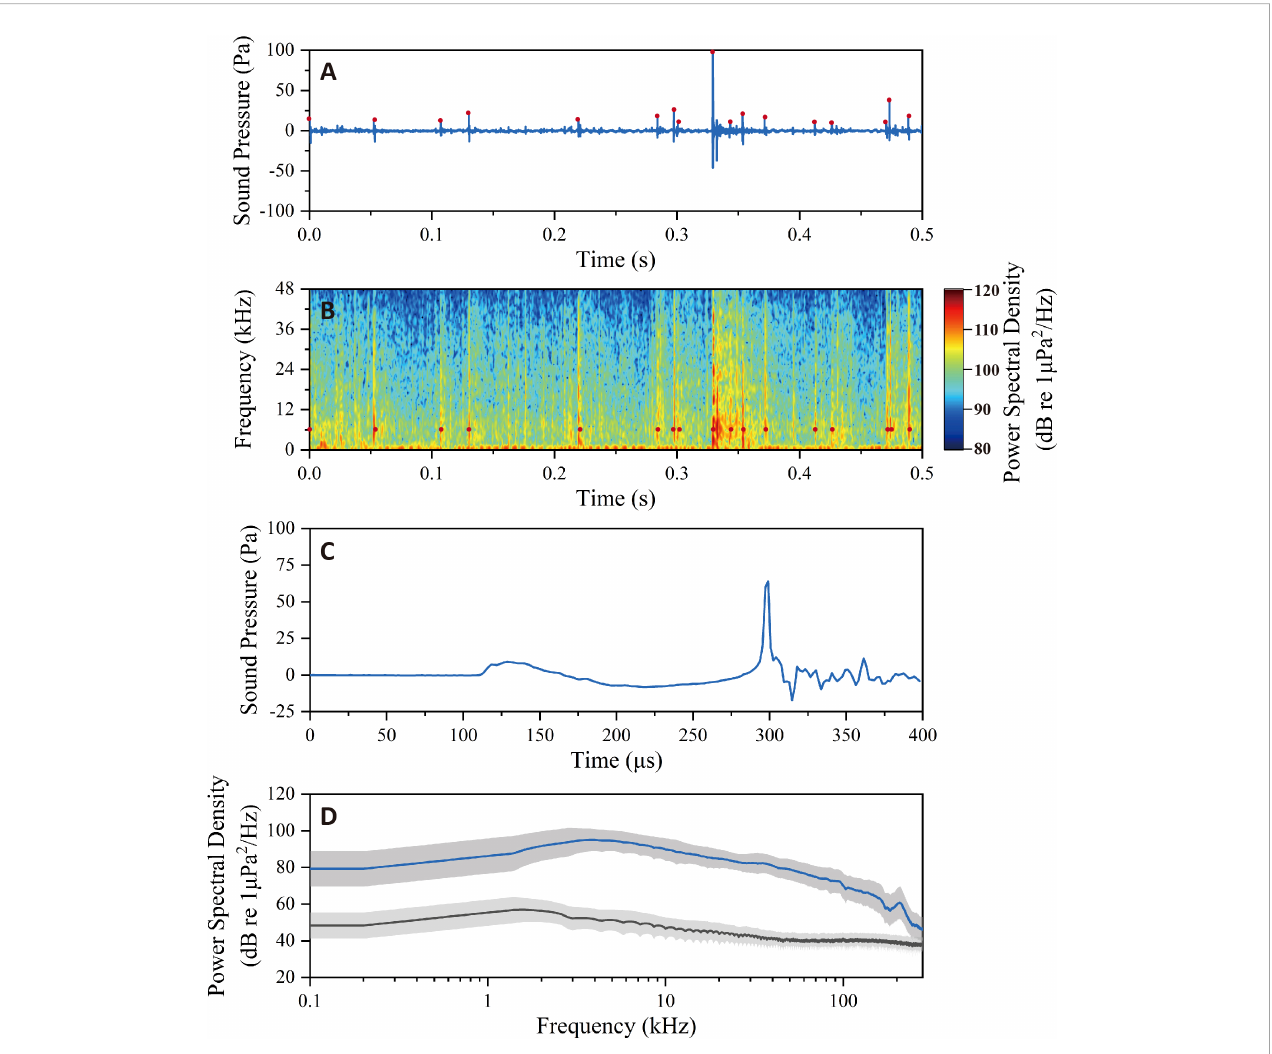
FIGURE 2 (A) A series of snaps in time domain and (B) time-frequency domain, with the red dots representing the detected snaps. (C) Waveform of a representative snap, showing a low amplitude precursor and a distinct high amplitude pulse. (D) Power spectral density of the snap (upper line) and its comparison to background noise (lower line). These data were recorded at site